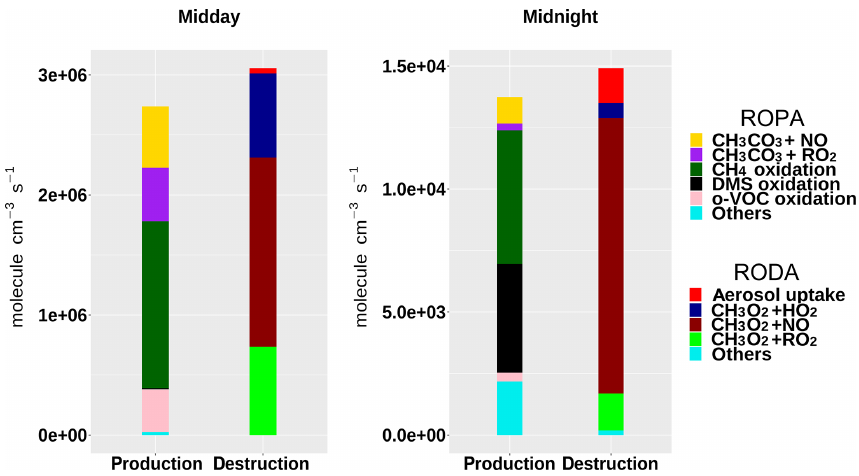
Figure 8. Rate of production (ROPA) and destruction (RODA) analyses of the methyl peroxy radical (CH 3 O 2 ) at midday and midnight of 1 August, during the TexAQS 2006 cruise of the NOAA research vessel Ronald H. Brown .